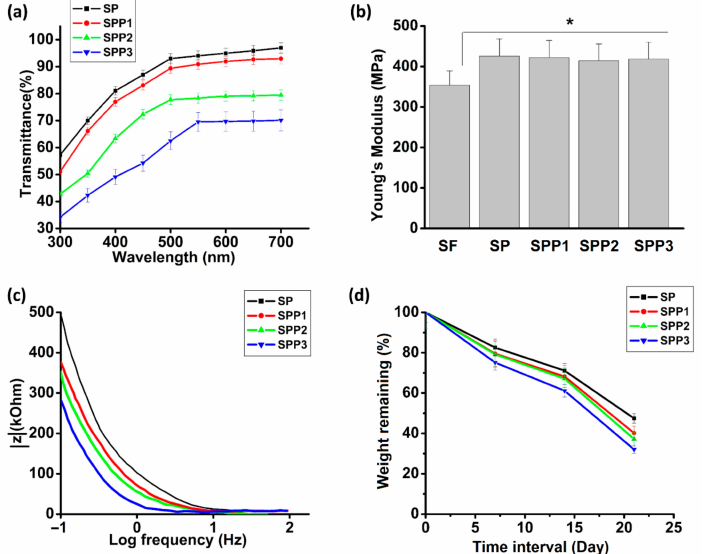
Figure 2. ( a ) Light transmittance and ( b ) Young’s modulus of di ff erent SF / PEDOT:PSS matrices. A significant di ff erence (* p < 0.05) in Young’s modulus (MPa) observed due to incorporation of PVA. ( c ) EIS (electrochemical impedance spectroscopy) measurements of fabricated matrices containing various concentrations of PEDOT:PSS. ( d ) The degradation of matrices at 37 ◦ C in Proteinase K over 21